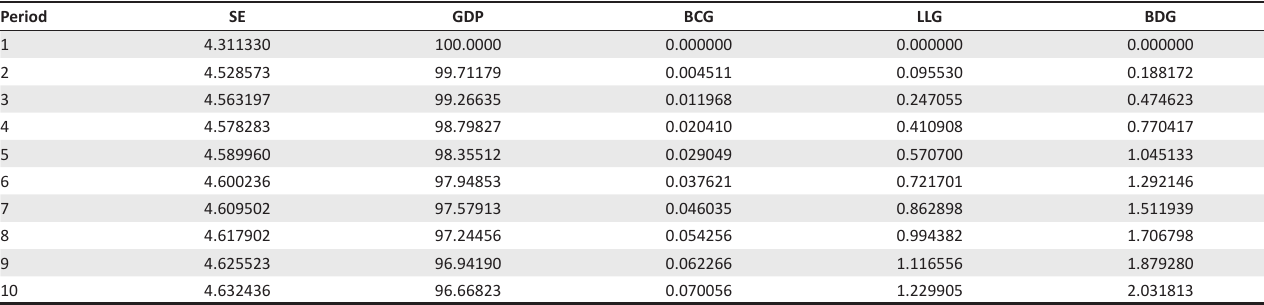
FIGURE 1: Impulse response function results, 1980–2014. Response to Cholesky, one SD innovations ± 2 SE. (a) response of GDPC to GDPC, (b) response of GDPC to BCGF, (c) response of GDPC to LLPG, response of GDPC to TABLE 6: Variance decomposition results of GDPC, 1980–2014.